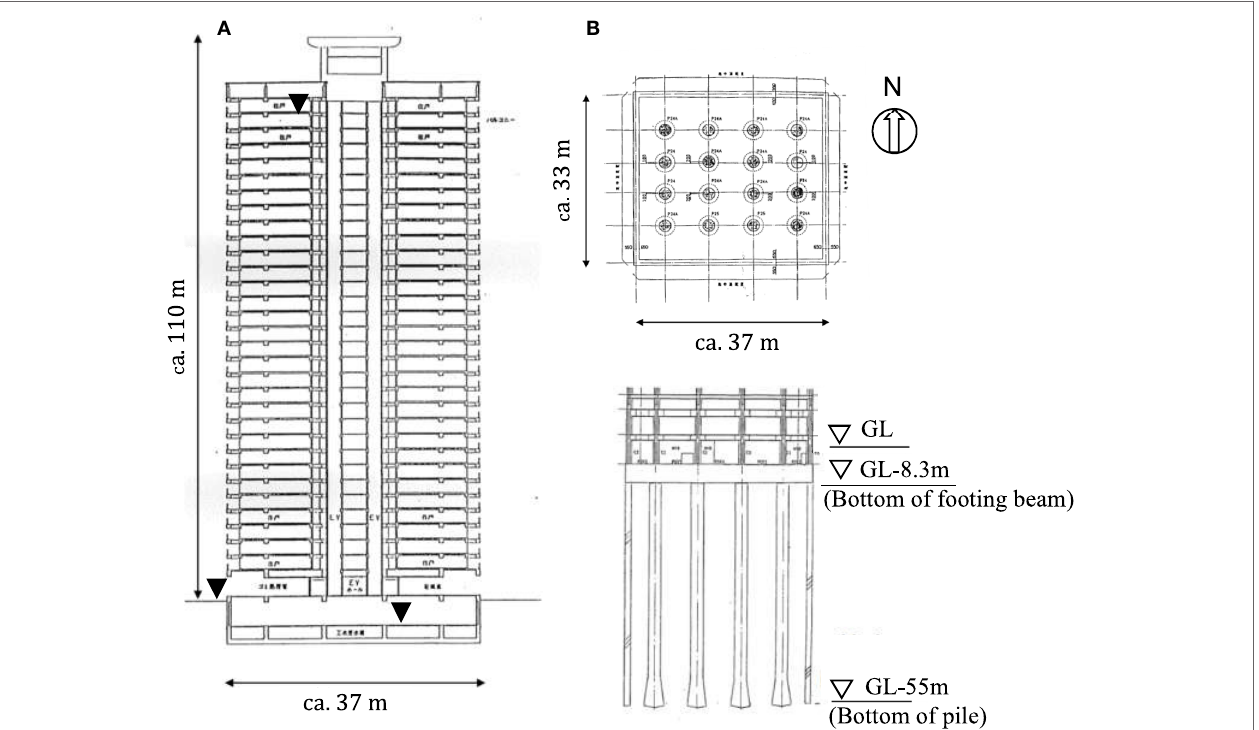
FigUre 1 | Profile of 32-story steel-reinforced concrete building. (a) Section of the frame structure high-rise ( ▾ : Observation points). (B) Plan view and section view of substructure.